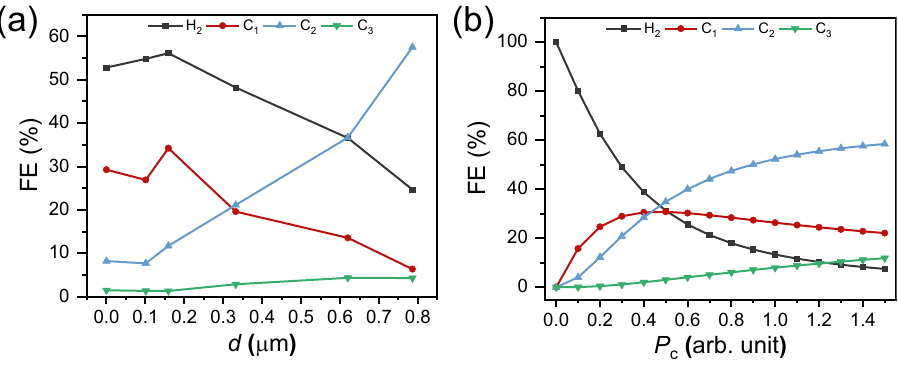
Fig. 6 | Microkinetic model. Comparison of FEs of H 2 (black), C 1 (red), C 2 (blue), and C 3 (green) from a experimental results as function of d and b model results as